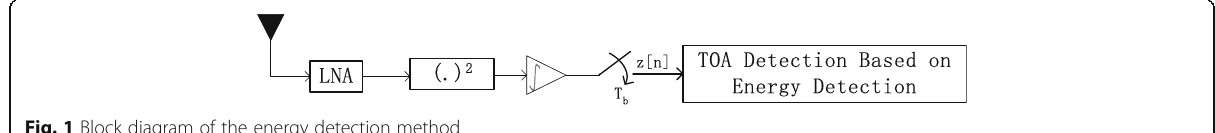
Fig. 1 Block diagram of the energy detection method